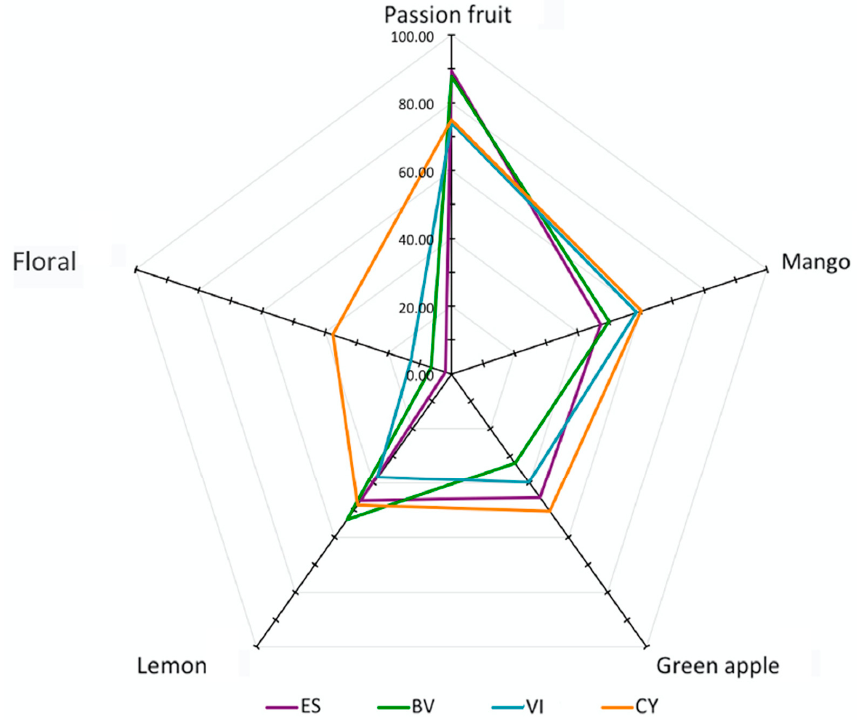
Figure 2. Sensory attributes of passion fruit wine fermented by commercial yeast strain ES488 (ES), BV818 (BV), VIC (VI) and CY3079 (CY) using a professional panel. The geometric mean (GM%) was used to assess the aromatic features of these passion fruit wine samples. Table 4. Volatile compounds in passion fruit wine fermented by commercial yeast strain ES488 (ES), BV818 (BV), VIC (VI) and CY3079 (CY) selected for partial least squares regression analysis (volatiles with OAV > 1 and esters with OAV >